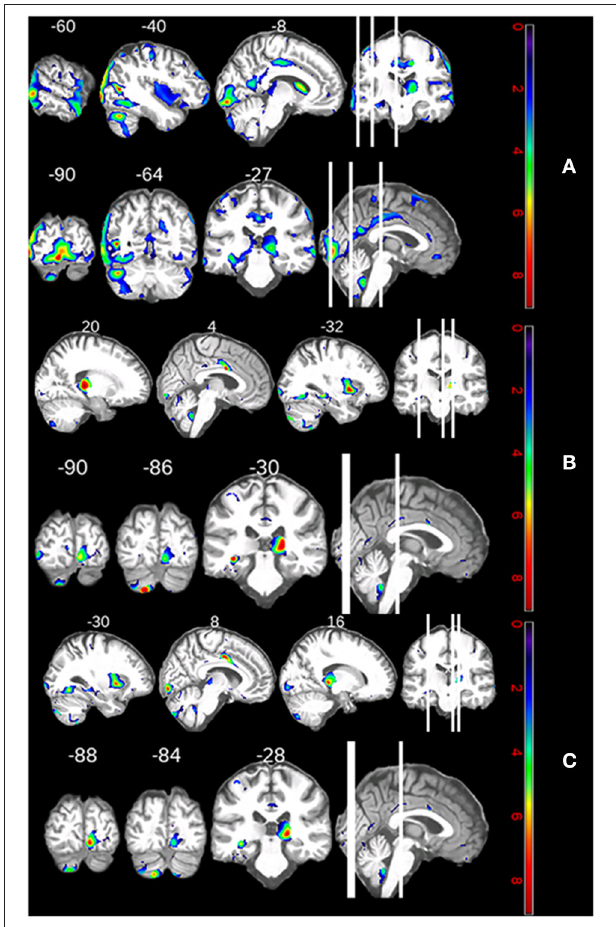
FIGURE 3 | (A) Neuroanatomical correlates of the patient’s declining shifting performance. (B) Neuroanatomical correlates of the patients’ declining semantic fluency performance. (C) Regional increases in atrophy over 5